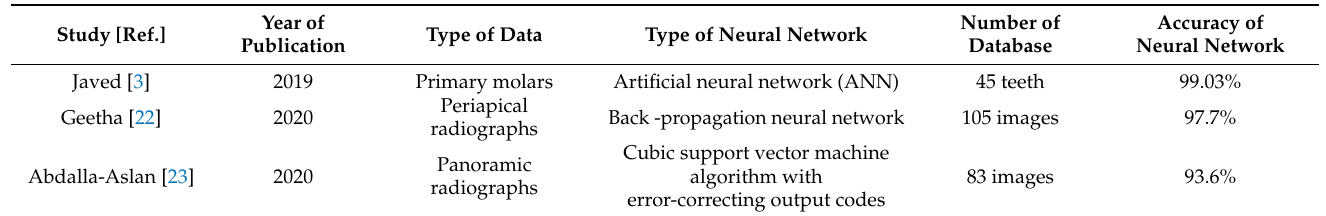
Table 1. Baseline characteristics of the studies included in the review by studying neural networks in restorative